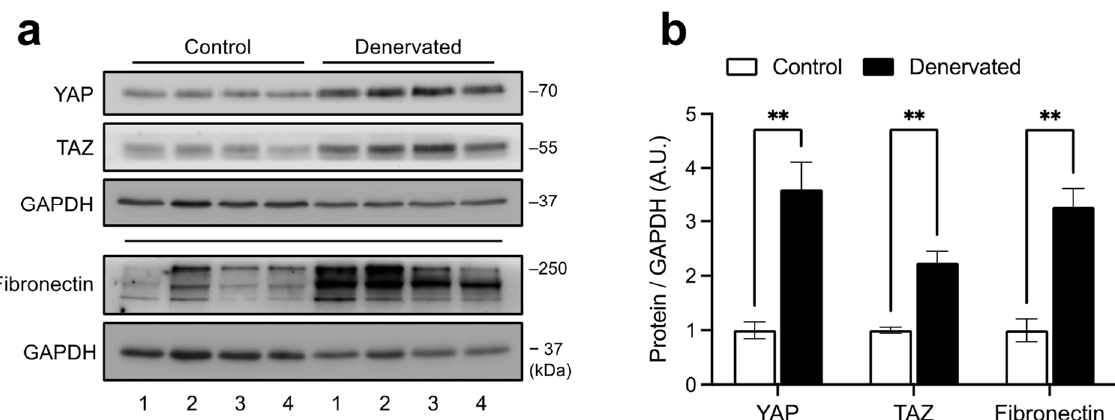
Figure 1. YAP/TAZ protein levels are increased in denervated skeletal muscles. ( a ) Western blot showing YAP/TAZ and fibronectin protein expressions in denervated and control (14 days post-denervation) TA muscles. Fibronectin and GAPDH were used as a fibrotic marker and loading control, respectively. For fibronectin, a second blot was carried out with the same samples. The numbers at the bottom indicate each independent mouse. ( b ) Densitometric analysis of YAP/TAZ and fibronectin signals normalized to their respective GAPDH. A.U. = arbitrary units. N = 4 independent mice. ** = p < 0.01; unpaired t test.